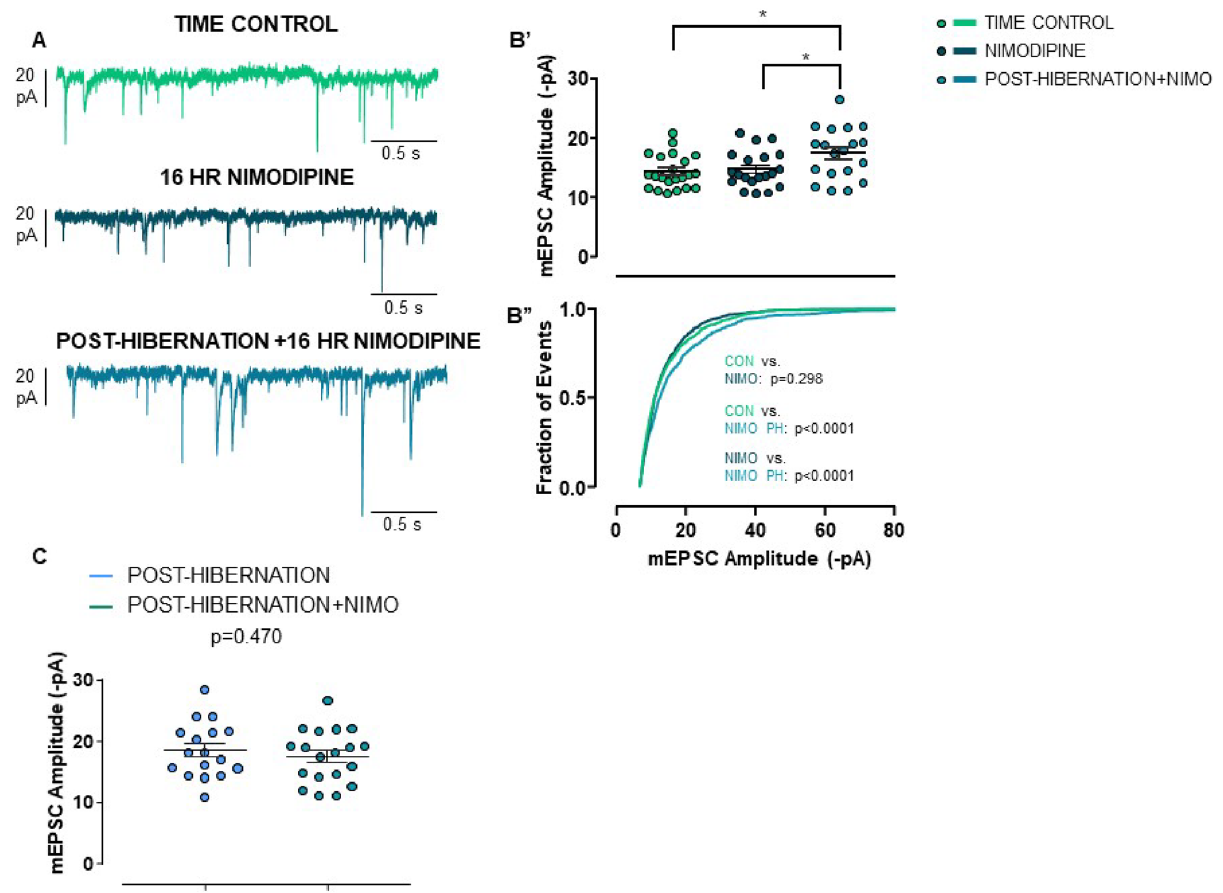
Figure 5. Block of L-type Ca 2+ channels does not increase mEPSC amplitude. ( A ) Example mEPSC traces recorded in whole-cell voltage clamp in time control (n = 22 from 6 animals), 10 µM nimodipine (n = 20 from 5 animals), and post-hibernation + nimodipine (n = 19 from 5 animals). ( B’ ) Cell-averaged mEPSC amplitudes and ( B’’ ) cumulative distribution of mEPSC amplitudes. Nimodipine exposure does not increase mean synaptic strength or alter the distribution of mEPSC amplitudes. After hibernation, exposure to nimodipine still results in enhanced synaptic strength. ( C ) Post-hibernation (n = 17 from 5 animals) and post-hibernation + nimodipine (n = 19 from 5 animals) have similar group means (unpaired t